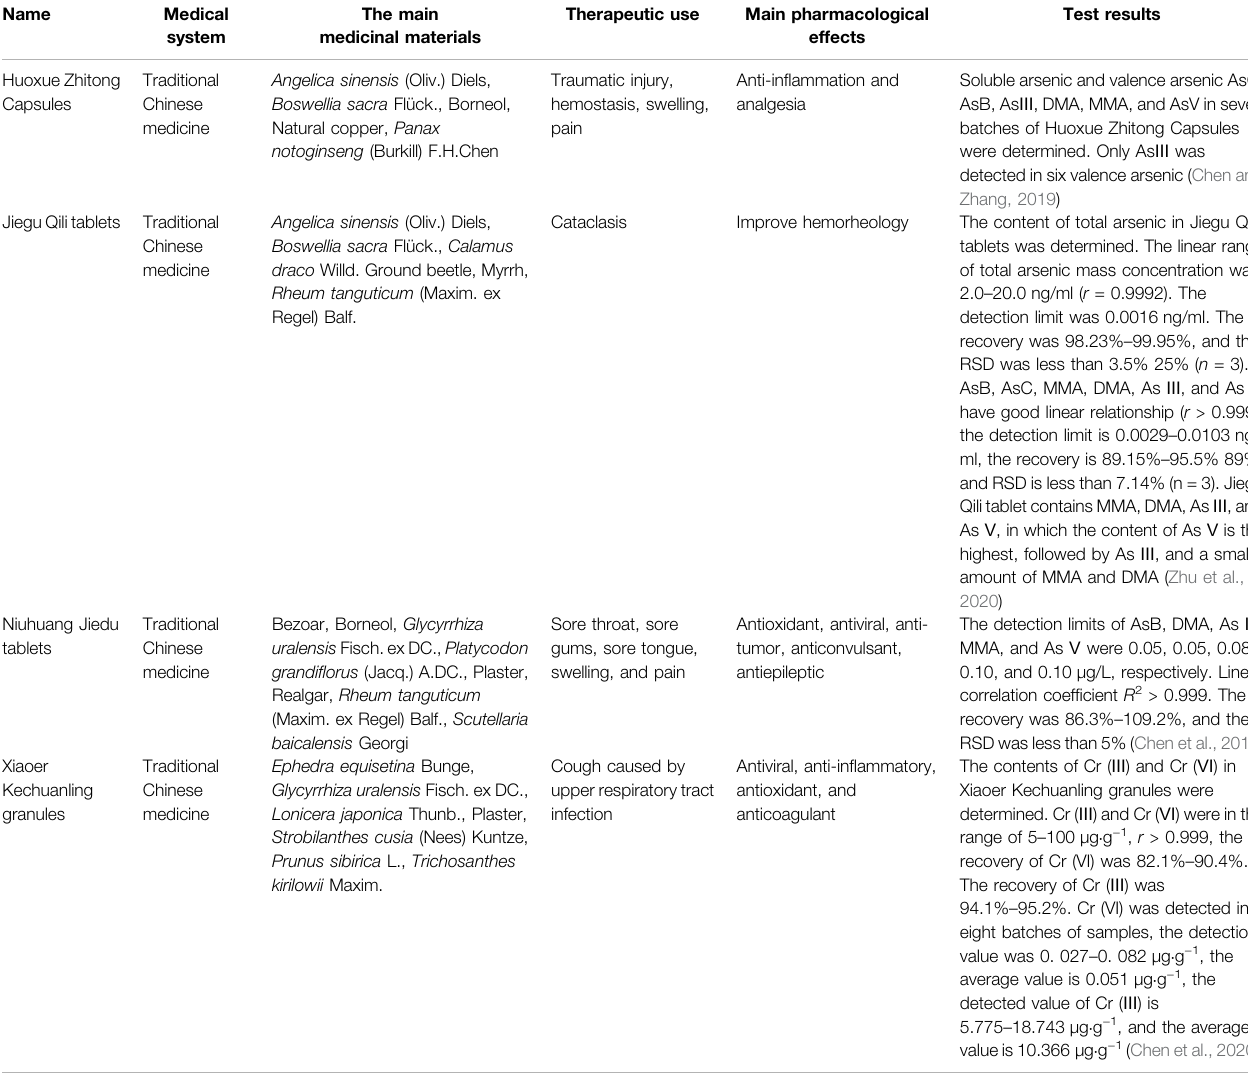
TABLE 12 | Application of HPLC-ICP-MS in Chinese patent